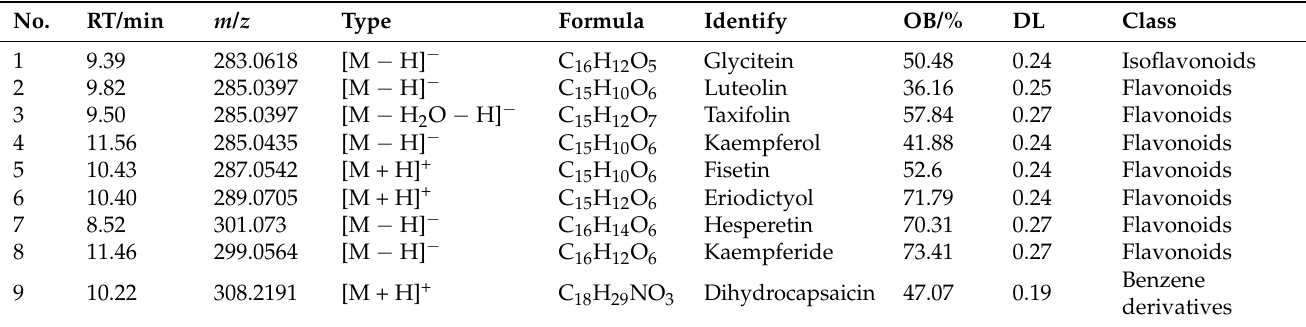
Table 1. Characterization of chemical constituents in